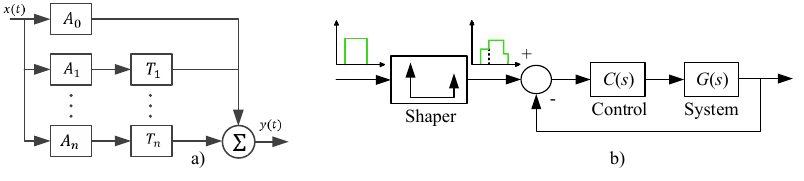
Figure 2. ( a ) Input shaper design using gains and delays and ( b ) input shaper used with the